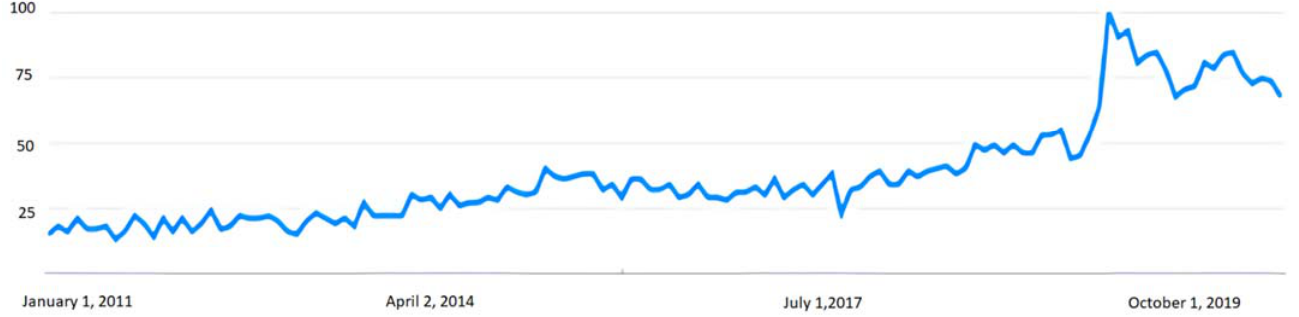
Figure 1. Number of searches for the term “meditation” between 2011 and 2021 in the West. Source: Google Trend.